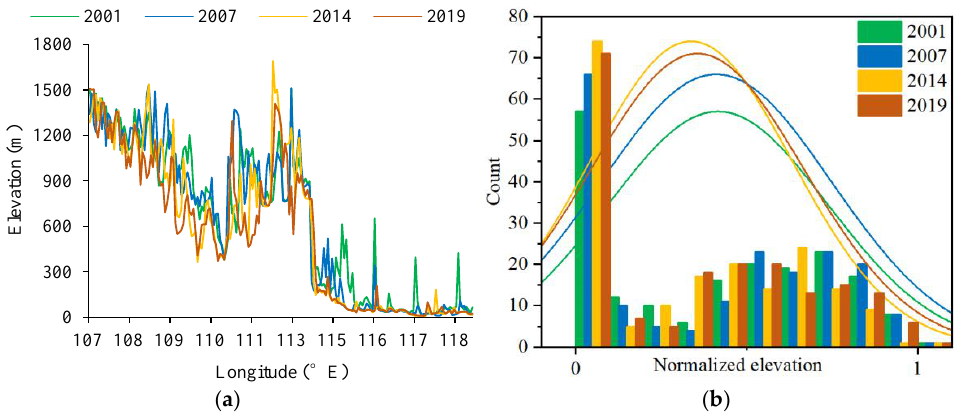
Figure 12. Change of elevation of the NLWW during the period 2001–2019. (Green, blue, orange and dark orange solid lines in ( a ) are the elevation change curves, and in ( b ) represent the cumulative distribution function curves of the statistical quantity of different normalized elevation values in 2001, 2007, 2014 and 2019, respectively.).